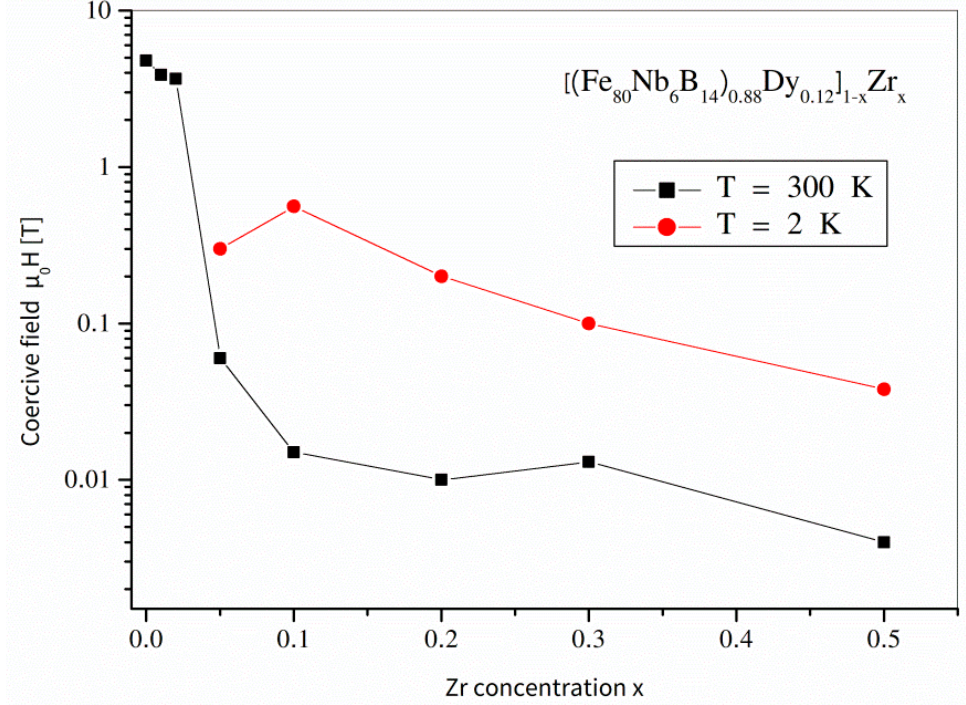
Figure 7. Coercive field H c for the [(Fe 80 Nb 6 B 14 ) 0.88 Dy 0.12 ] 1 − x Zr x (0 ≤ x ≤ 0.5) alloys determined at 300 K and 2 K.